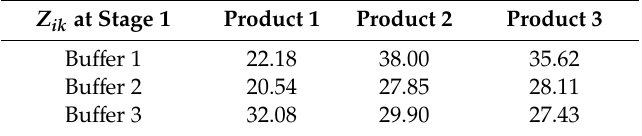
Table 4. The hedging points of the product types in the buffers at stage 1.